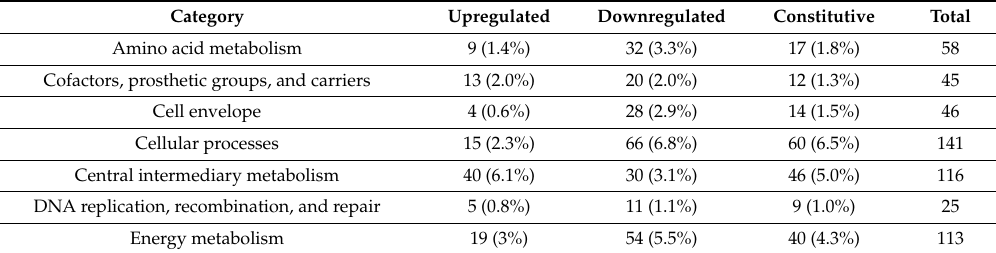
Table 1. Categories of Expressed and Constitutive Genes. Each identified gene was placed in the corresponding category as defined by Kaneko et al. [22]. The values in parenthesis are the percentage that each category represents of the total number of transcripts in each group (up-regulated, down-regulated, or constitutive). The transcripts included in either the up- (>2-fold) or down-regulated (<2-fold) columns were genes that display the respective values at all six time points. Category Upregulated Downregulated Constitutive Total Amino acid metabolism Cofactors, prosthetic groups, and